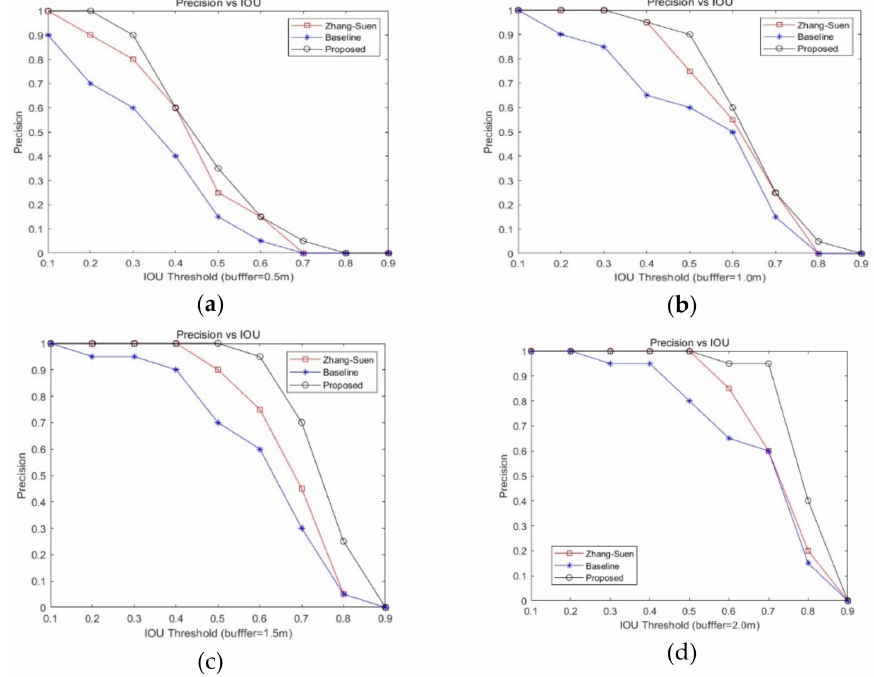
Figure 16. Precision curves of the proposed and compared methods, evaluated in study area A, with different IOU under four buffer distance: ( a ) 0.5 m, ( b ) 1.0 m, ( c ) 1.5 m, ( d ) 2.0 m. The proposed method offers the highest precision for all four